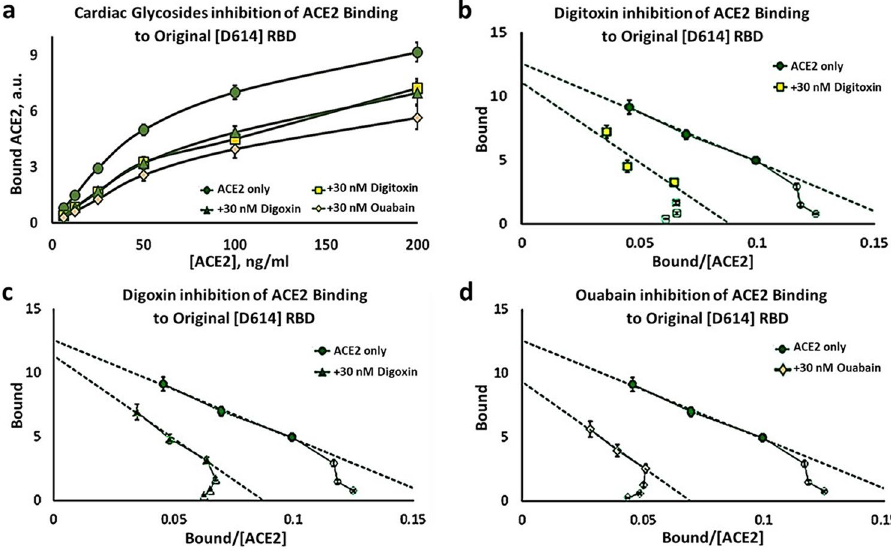
Figure 4. Inhibition of ACE binding to the Original [D614] RBD by cardiac glycoside drugs. ( a ) Substrate- binding plots for inhibition by digitoxin, digoxin and ouabain (30 nM). ( b – d ) Eadie–Hoffstee plots of data in Part ( a ) for digitoxin inhibition ( b ), digoxin inhibition ( c ), and ouabain inhibition ( d ). Each point is the average ± SE for N = 5–6 independent experiments.